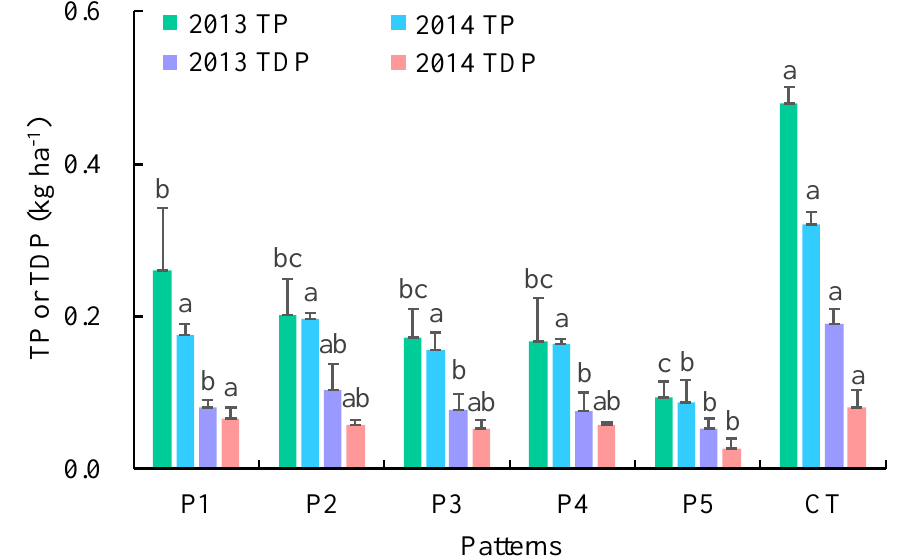
Figure 7. Phosphorus (P) loss via runoff under different crop-mulberry planting patterns. The same letters above the bars indicate no significant difference and different letters indicate significant differences between these groups (p <